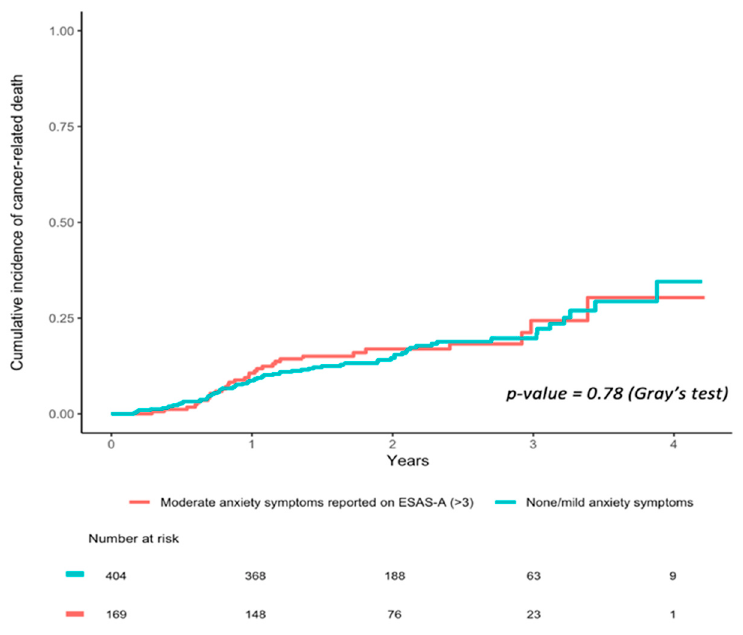
Figure 2. Cumulative incidence of cancer-related death in patients with moderate/severe vs. none/mild ESAS anxiety symptoms reported at diagnosis.